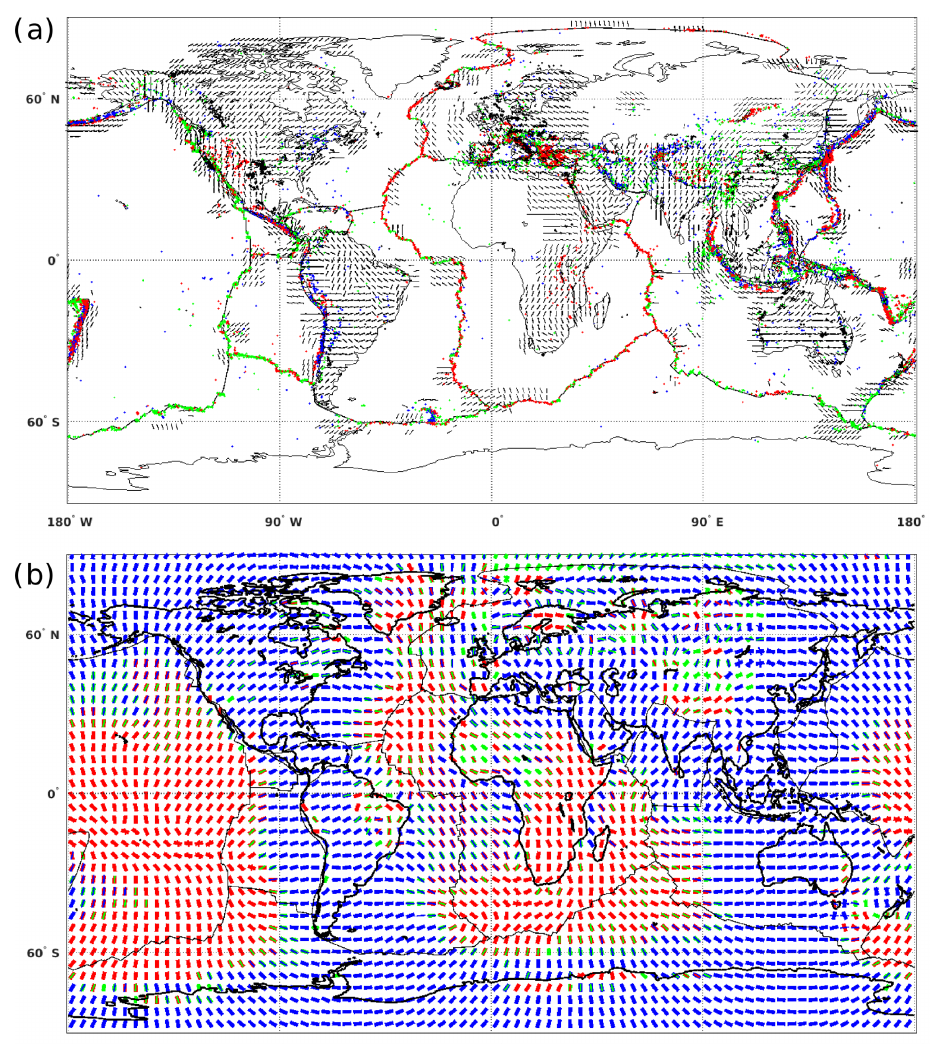
Figure 5. (a) Interpolated World Stress Map 2016 (Heidbach et al., 2016), data on a grid of 2.5 ◦ × 2.5 ◦ , using only stress orientation with a constant search radius 270km, and (b) predicted SH max orientation and regime from total stress contribution with TM1 (plotted in thin bars) over TM2 (thick bars) upper mantle thermal structures. Colors of dots (a) and bars (b) indicate observed or predicted stress regime with red for normal faults or tensile stress, blue for thrust faults or compressive stress and green for strike-slip faults or intermediate stress (one principal horizontal stress positive, one